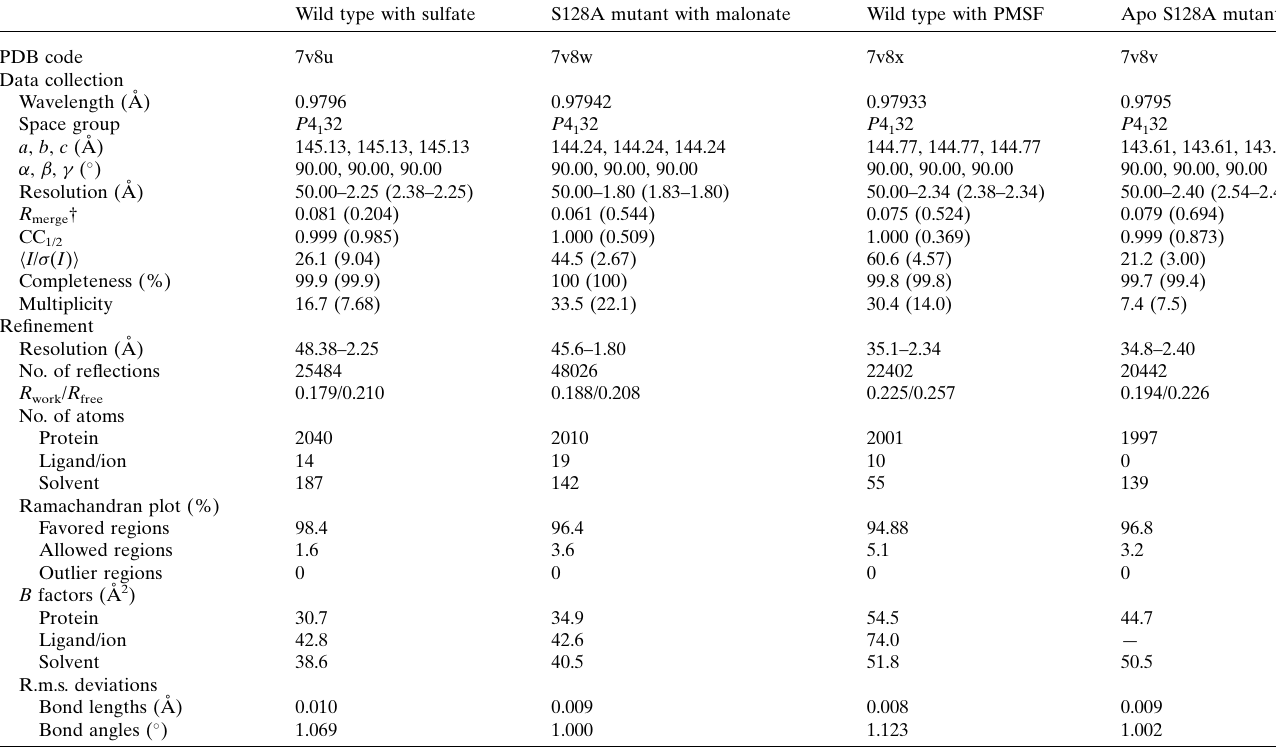
Table 1 Data-collection and refinement statistics. Values in parentheses are for the highest resolution